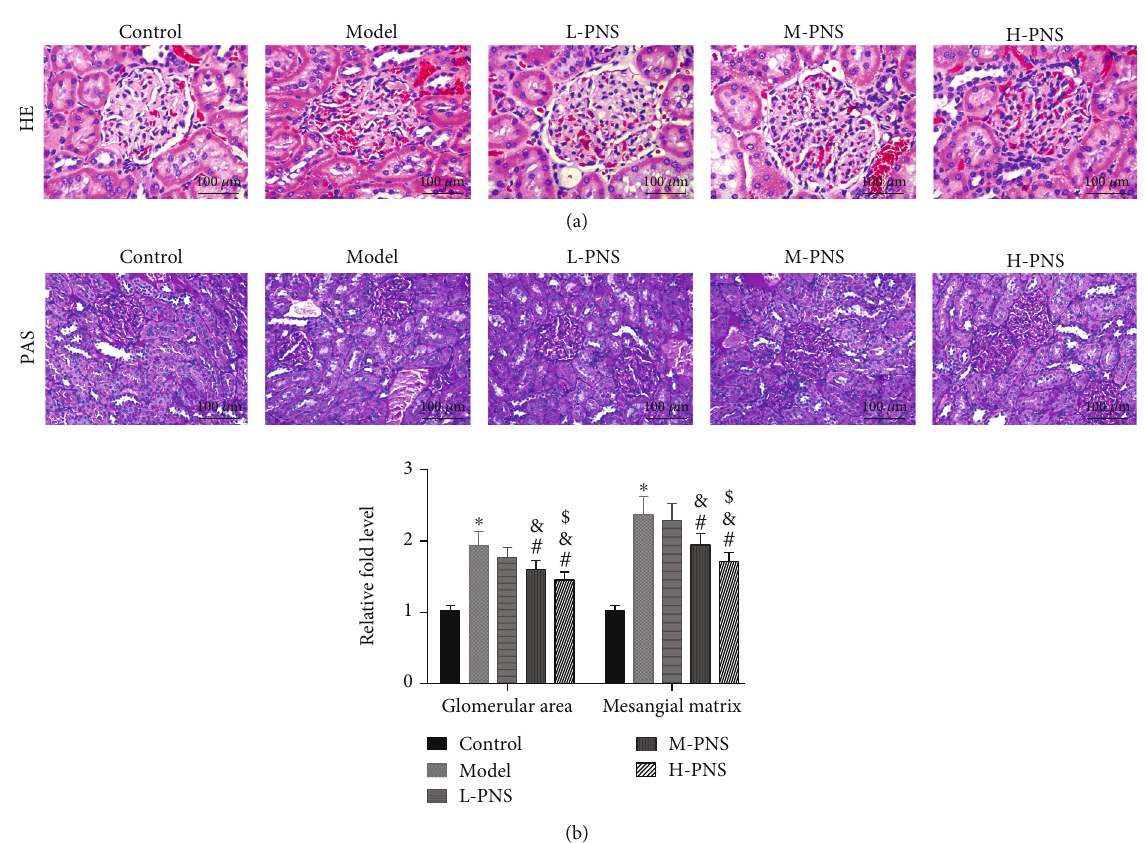
Figure 3: Renal histopathological changes in mice ((a) HE staining. (b) PAS staining, glomerular area, and mesangial matrix expansion of mice; original magni fi cation: × 400; ∗ P < 0 : 05 vs. control; # P < 0 : 05 vs. model; & P < 0 : 05 vs. L-PNS; $ P < 0 : 05 vs.